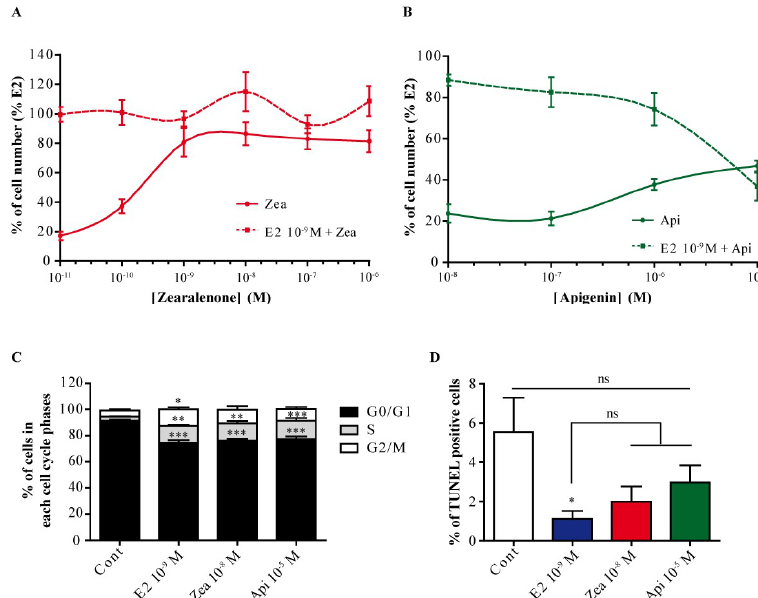
Figure 4. Effect of zearalenone and apigenin on MCF-7 proliferation. MCF-7 cells were treated with various doses of zearalenone ( A ) or apigenin ( B ) alone (solid lane) or in combination with 10 − 9 M E2 (dotted line) for 6 days, and the cell number was determined by counting. The results are expressed as the percentage of the cell numbers counted after E2 treatment and are the means ± SEM of three to four independent experiments. For the cell cycle ( C ) and apoptosis ( D ) assays, MCF-7 cells were treated for 3 days with 10 − 9 M E2, 10 − 8 M zearalenone or 10 − 5 M apigenin. The cell cycle was analyzed by flow cytometry after propidium iodide staining. The results are expressed as the percentage of cells in each phase of the cell cycle and are the means ± SEM of three to four independent experiments. Apoptosis analysis was performed by a terminal deoxynucleotidyl dUTP nick end labeling (TUNEL) assay, and the percentage of apoptotic cells was assessed with an Array Scan VTI. The results are expressed as the percentage of TUNEL-positive cells. ns indicates a non-significative p -value, * indicates a p -value < 0.05, ** indicates a p -value < 0.01, and *** indicates a p -value < 0.001 by one-way ANOVA followed by Dunnett’s post hoc test for comparison of the control treatment with the other